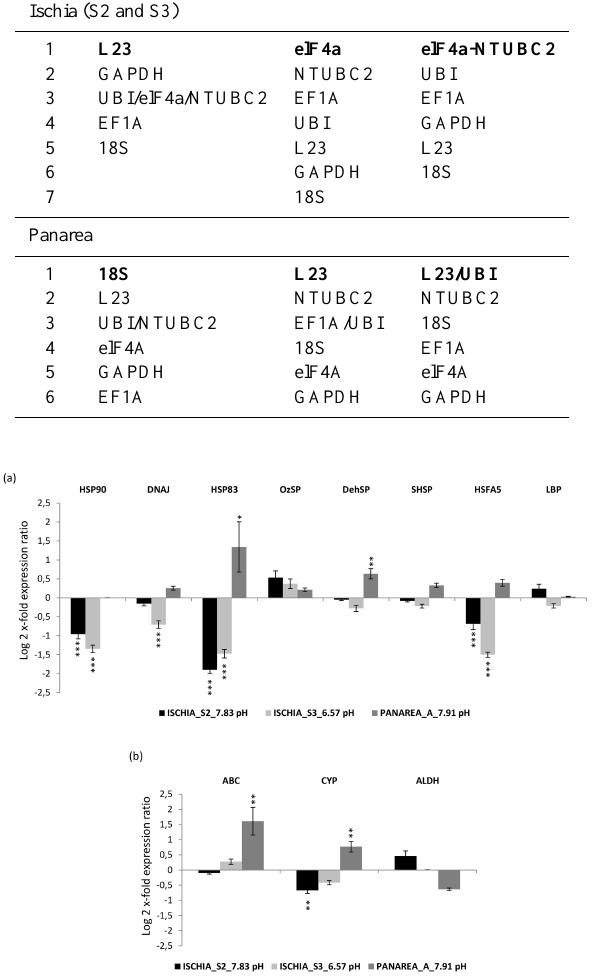
Figure 1. Expression levels of P. oceanica heat shock pro- tein (a) and primary metabolism genes (b) from plants collected at Ischia (S2 and S3 sites, with pH 7.83 and 6.57, respectively) in relation to the control site (pH 8.14), and at Panarea (pH 7.91) in relation to its control site (pH 8.17).